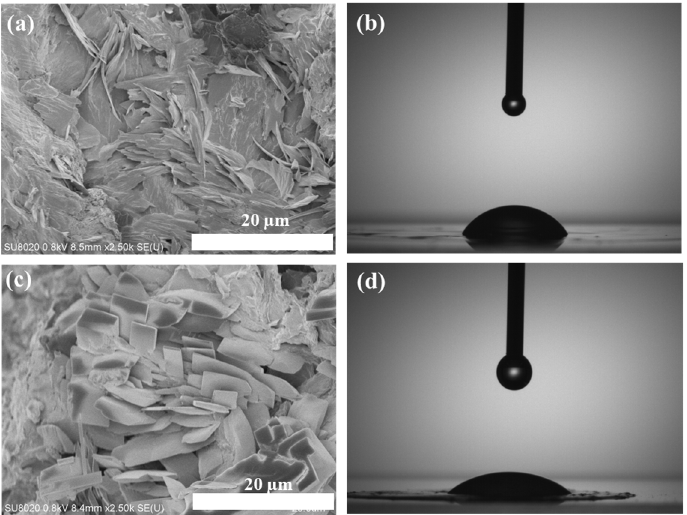
Figure 4. FESEM images of ( a ) PCL and ( b ) CA of water on PCL as well as FESEM images in ( c ) and ( d ) that on PCL-g-MA synthesized from 3.375 g PCL, 3.000 g MA and 1.120 g DBPO for 18 h.